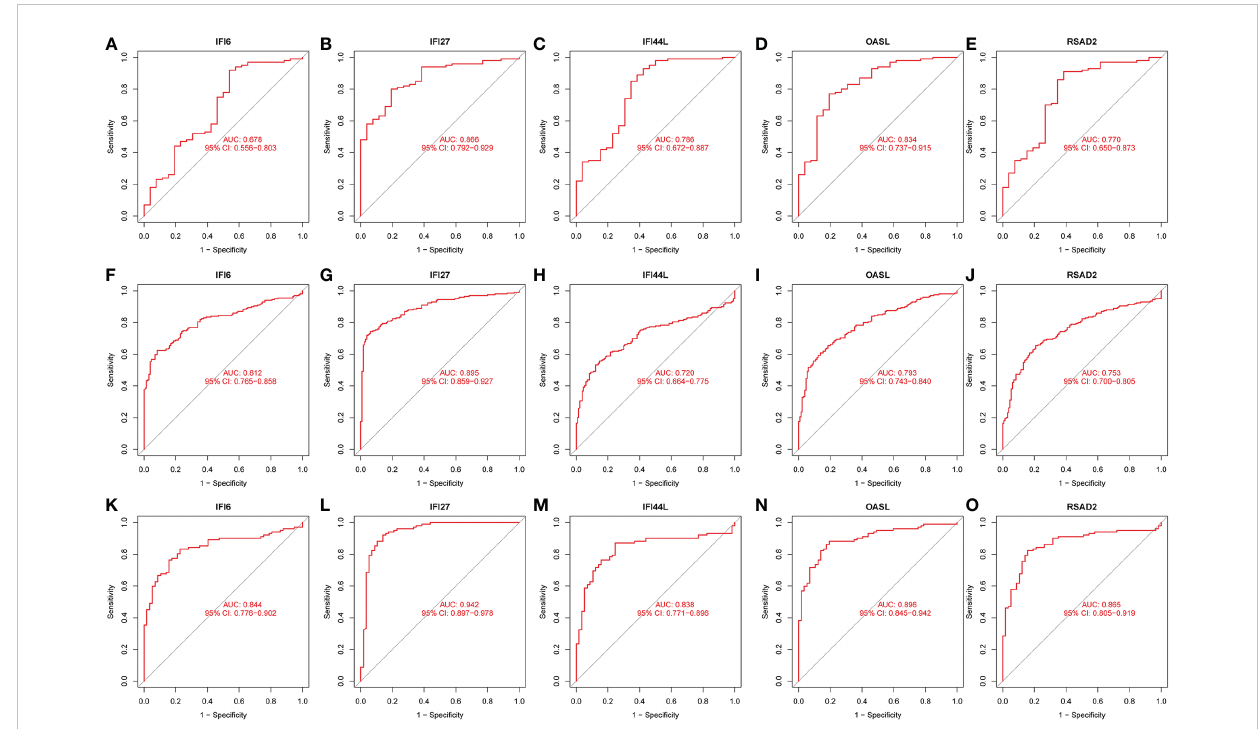
FIGURE 9 ROC analysis of HUB gene. (A) ROC of IFI6 in the GSE157103 dataset. (B) ROC of IFI27 in the GSE157103 dataset. (C) ROC of IFI44L in the GSE157103 dataset. (D) ROC of OASL in the GSE157103 dataset. (E) ROC of RSAD2 in the GSE157103 dataset. (F) ROC of IFI6 in the GSE111368 dataset. (G) ROC of IFI27 in the GSE111368 dataset. (H) ROC of IFI44L in the GSE111368 dataset. (I) ROC of OASL in the GSE111368 dataset. (J) ROC of RSAD2 in the GSE111368 dataset. (K) ROC of IFI6 in the GSE101702 dataset. (L) ROC of IFI27 in the GSE101702 dataset. (M) ROC of IFI44L in the GSE101702 dataset. (N) ROC of OASL in the GSE101702 dataset. (O) ROC of RSAD2 in the GSE101702